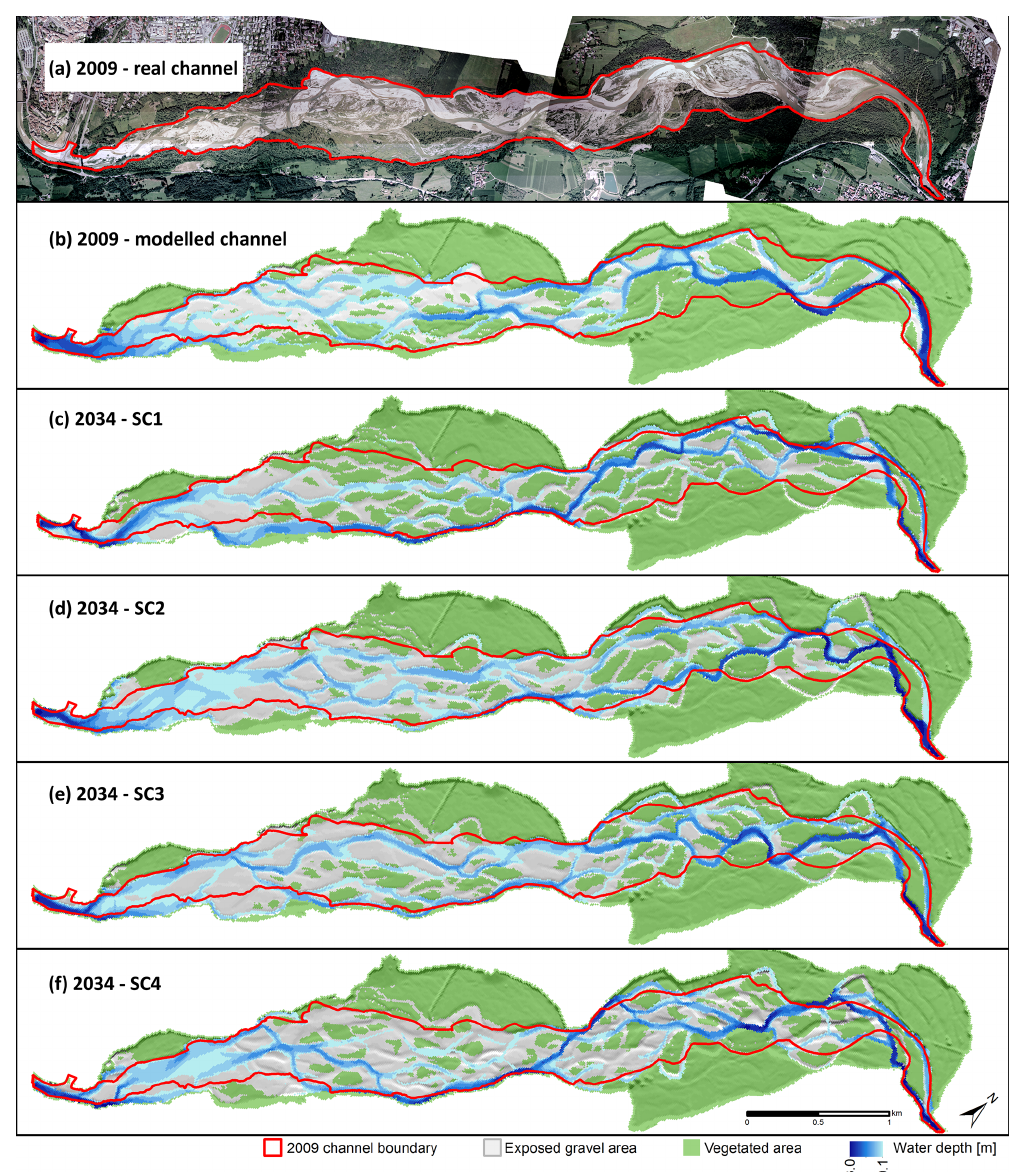
Figure 6. (a) 2009 real channel, (b) 2009 modelled channel used as starting point for the scenario runs; (c–f) results of scenarios 1–4 at the end of the runs